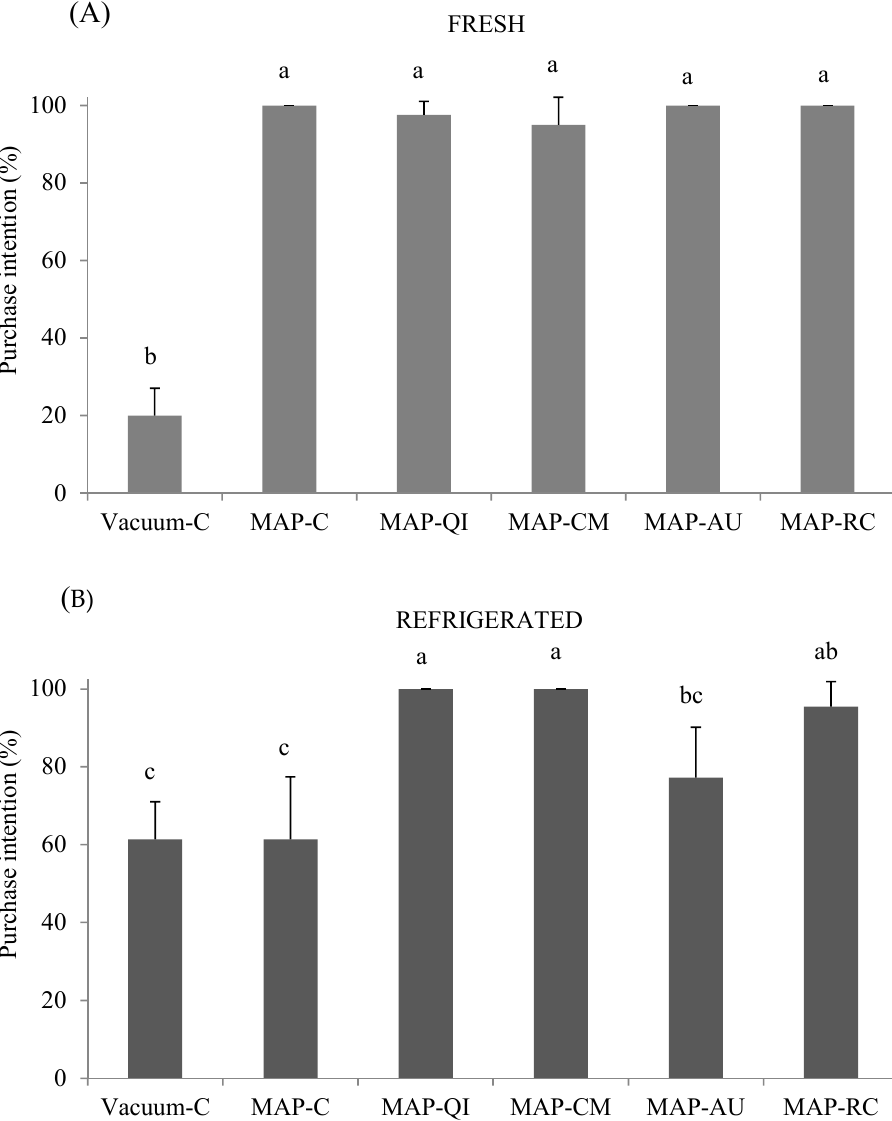
Figure 4. Consumers’ purchase intention (%) after visual assessment of fresh ( A ) and refrigerated ( B ) lamb cutlets (mean ± standard deviation). Sample description: Vacuum-C (cutlets packed in a vacuum package and no added extract), MAP-C (cutlets packed in a High-Ox-MAP and no added extract), MAP-QI (cutlets packed in High-Ox-MAP and treated with QI extract), MAP-CM (cutlets packed in a High-Ox-MAP and treated with CM extract), MAP-AU (cutlets packed in a High-Ox-MAP and treated with AU extract) and MAP-RC (cutlets packed in a High-Ox-MAP and treated with RC extract). a–c Different letters on top of bars denote significant differences between treatments.